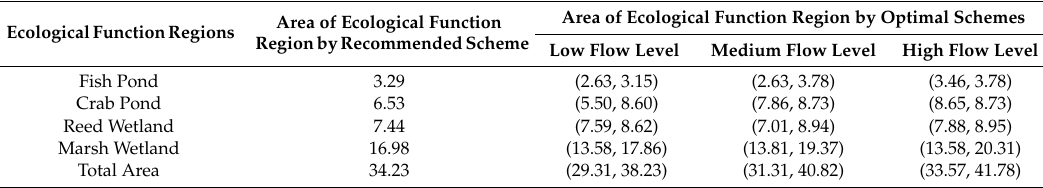
Table 5. The area of ecological function region recovered before and after the optimization of the ecological water supplement scheme (10 3